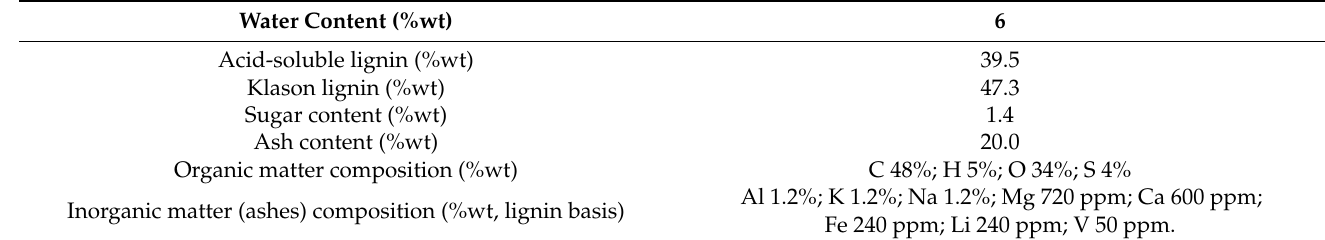
Table 1. Chemical composition of Kraft lignin. Water Content (%wt) 6 Acid-soluble lignin